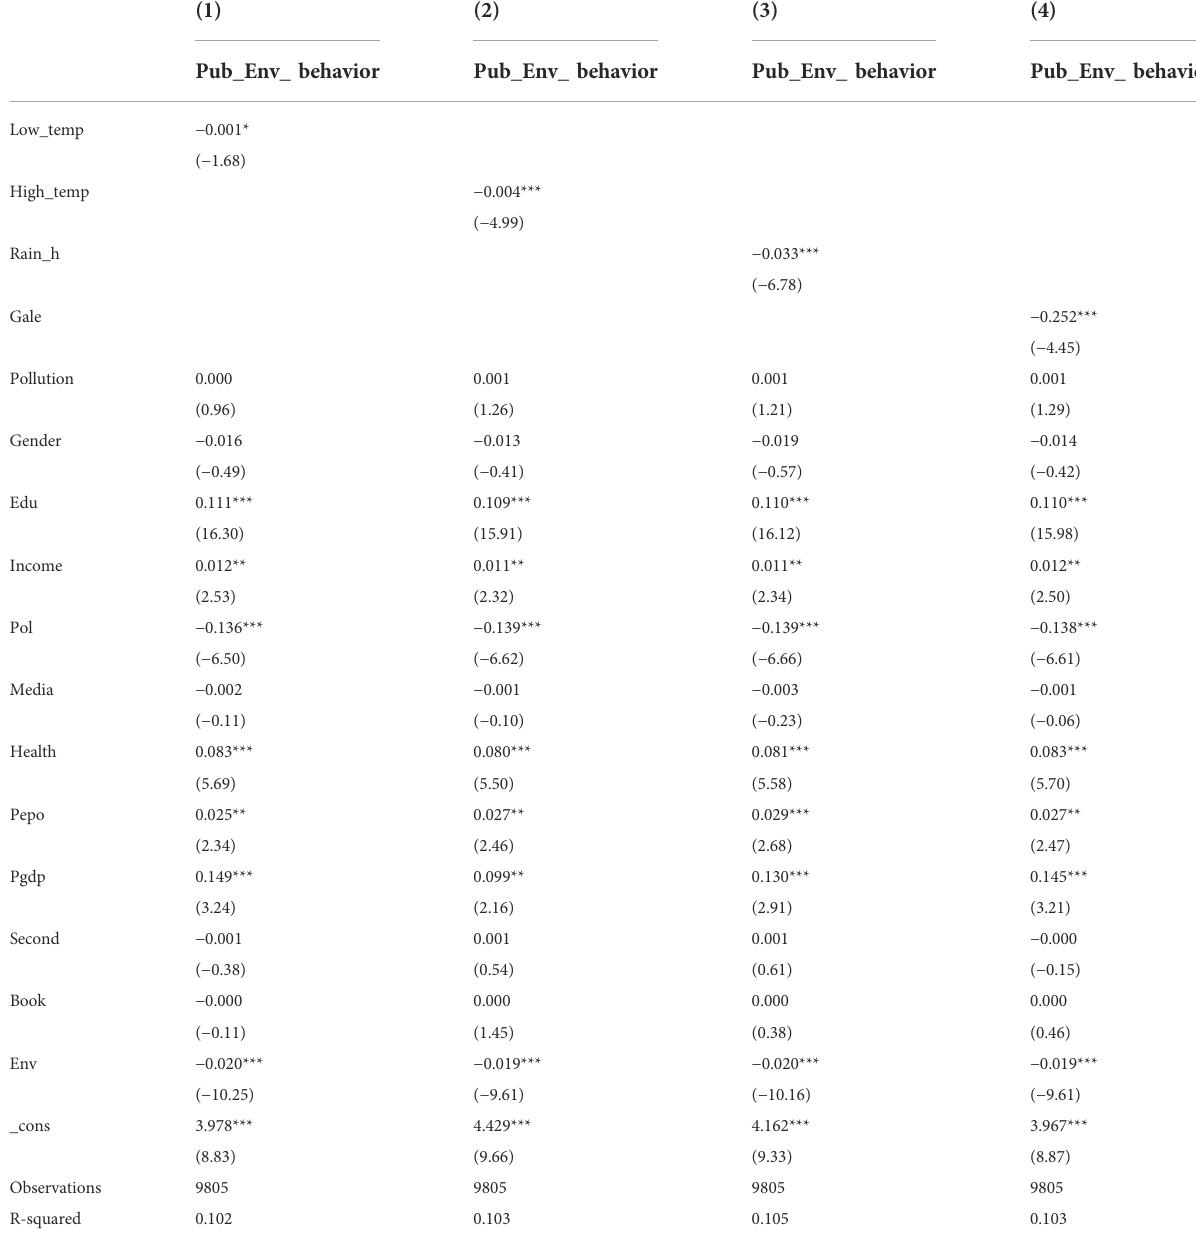
TABLE 8 Replacement of weather indicators